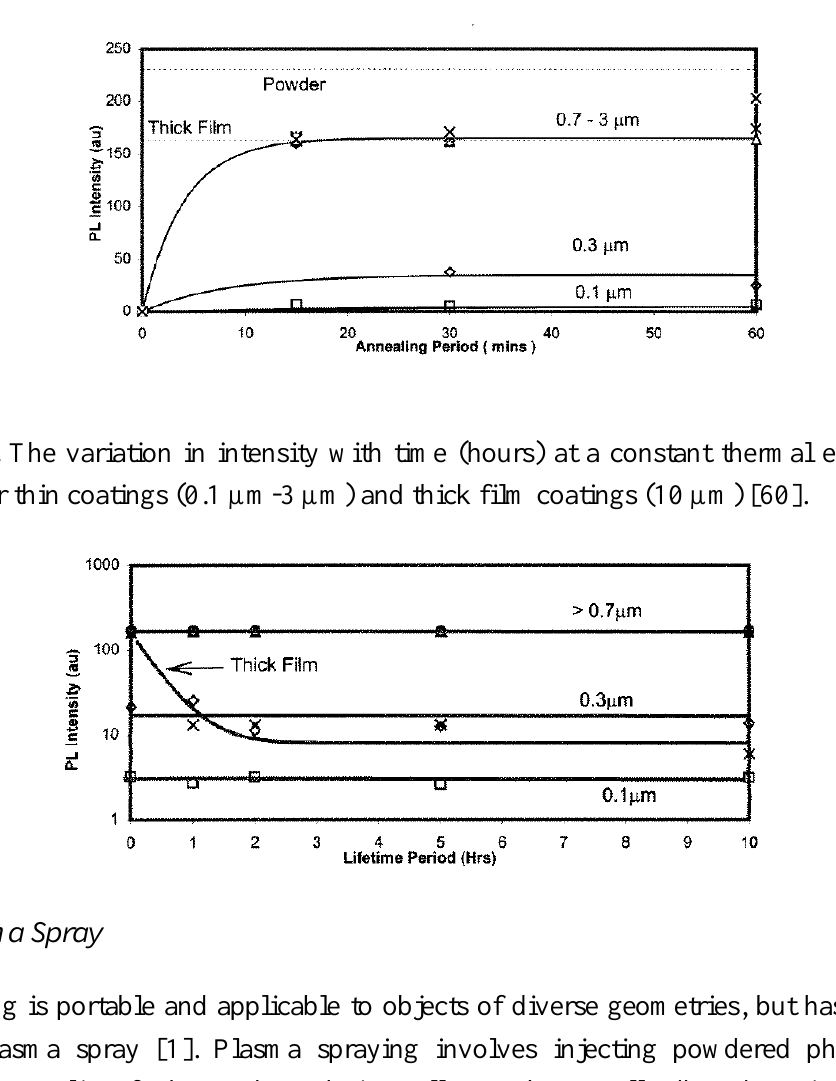
Figure 29. Intensity of thin coatings (0.1 µm-3 µm) after annealing at 1,200 o C compared to thick film (10 µm) and powdered Y